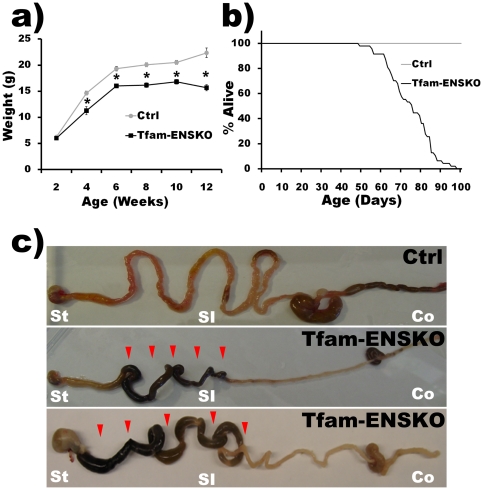
Tfam-ENSKOs develop progressive GI dysfunction characterized by intestinal pseudo-obstruction.
a
) Growth curve of Tfam-ENSKO mice and control littermates. Tfam-ENSKOs are initially indistinguishable from control mice, but begin to exhibit poor growth at 4 weeks of age (n≥10 mice per genotype at each time point). b
) Survival curve of Tfam-ENSKO mice and control littermates. Tfam-ENSKO mice die prematurely beginning at 60 days old. By 90 days, nearly all Tfam-ENSKO mice are dead. n = 47 mice. c
) Photograph of gastrointestinal tract of 11-12 week old control and Tfam-ENSKO mice depicts their typical appearance. Arrowheads indicate regions of dilation and accumulation of luminal contents. St: stomach, SI: small intestine, Co: colon.